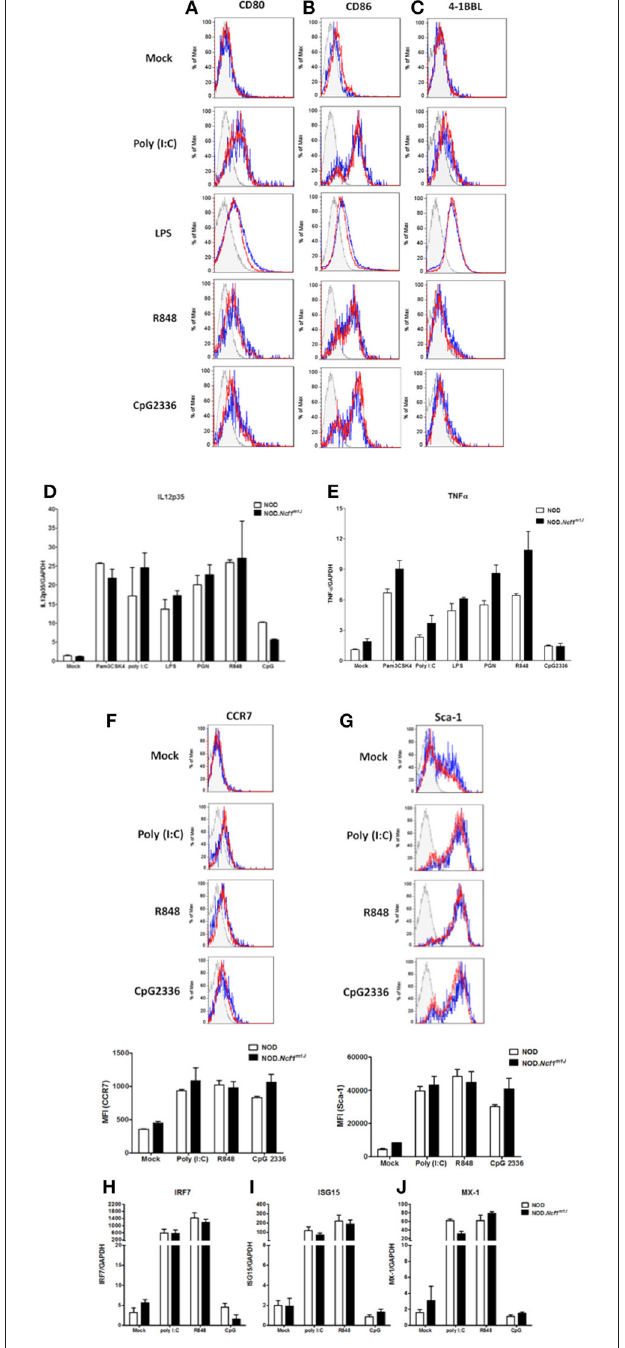
FIGURE 2 | Maturation of DC from NOD and NOD- Ncf1 m1J mice with TLR ligands results in comparable upregulation of surface co-stimulatory molecules, cytokine transcription, and Type 1 interferon response genes. Histogram surface staining of BMDC from NOD and NOD- Ncf1 m1J for (A) CD80, (B) CD86, and (C) 4-1BBL after 24h incubation with media alone (Mock), 25 µ g/mL poly (I: C), 100ng/mL LPS, 1 µ g/mL R848, or 5 µ g/mL CpG2336. Real-time quantitative PCR was performed for the target genes (D) IL12p35 and (E) TNF α in DCs after 12h stimulation with: media alone (Mock) 100ng/mL Pam3CSK4, 10 µ g/mL PGN, 25 µ g/mL poly (I: C), 100ng/mL LPS, (Continued)